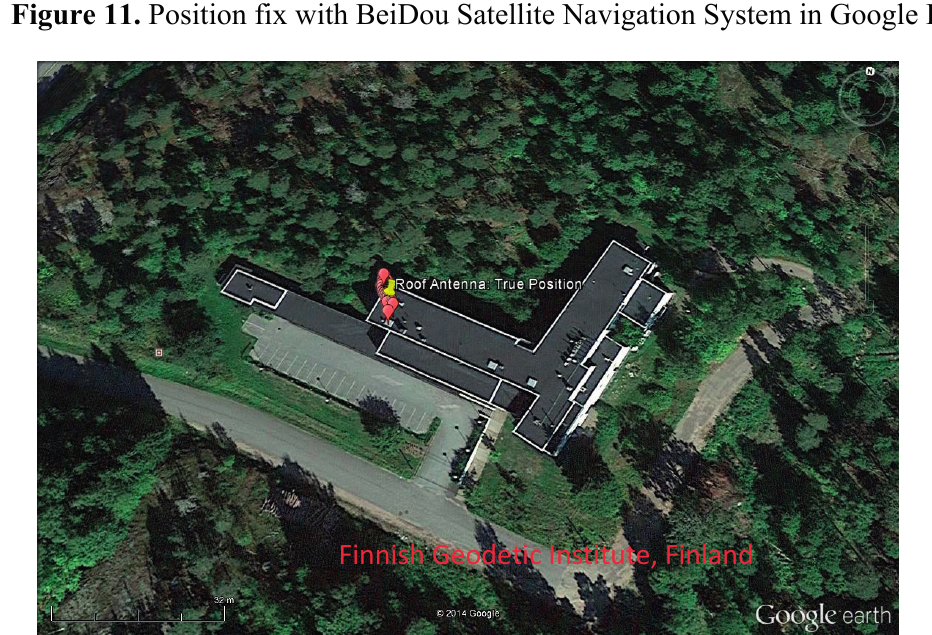
Figure 11. Position fix with BeiDou Satellite Navigation System in Google Earth.